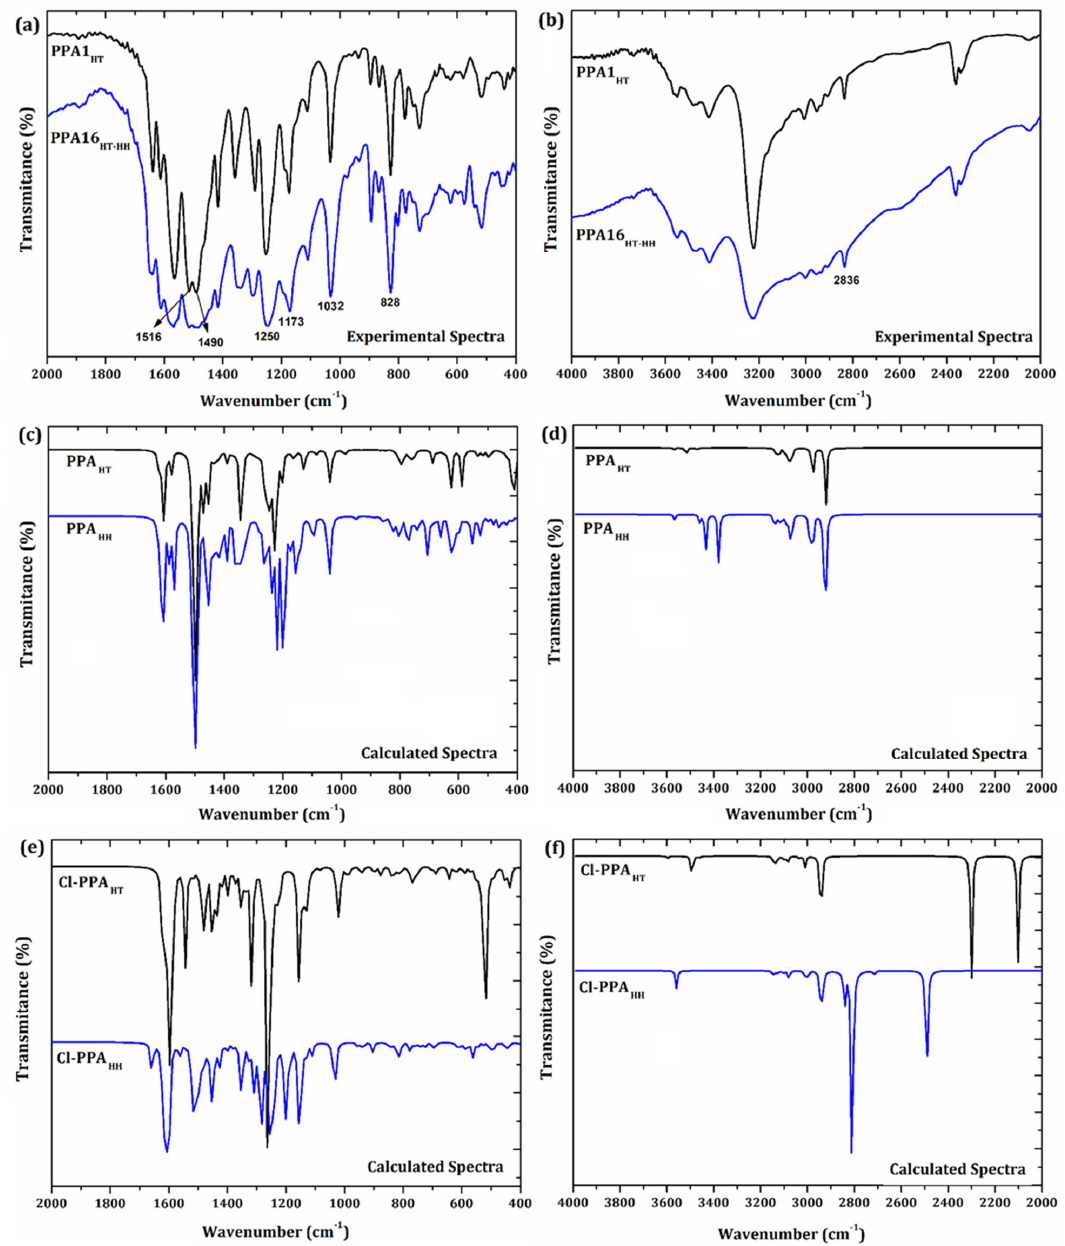
Figure 10. Experimental FTIR spectra of PPA1 HT and PPA16 HT-HH : ( a ) from 2000 cm − 1 to 400 cm − 1 and ( b ) from 4000 cm − 1 to 2000 cm − 1 ; calculated FTIR spectra of PPA HT and PPA HH : ( c ) from 2000 cm − 1 to 400 cm − 1 and ( d ) from 4000 cm − 1 to 2000 cm − 1 ; and calculated spectra of Cl–PPA HT and Cl–PPA HH : ( e ) from 4000 cm − 1 to 2000 cm − 1 and ( f ) from 4000 cm − 1 to 2000 cm − 1